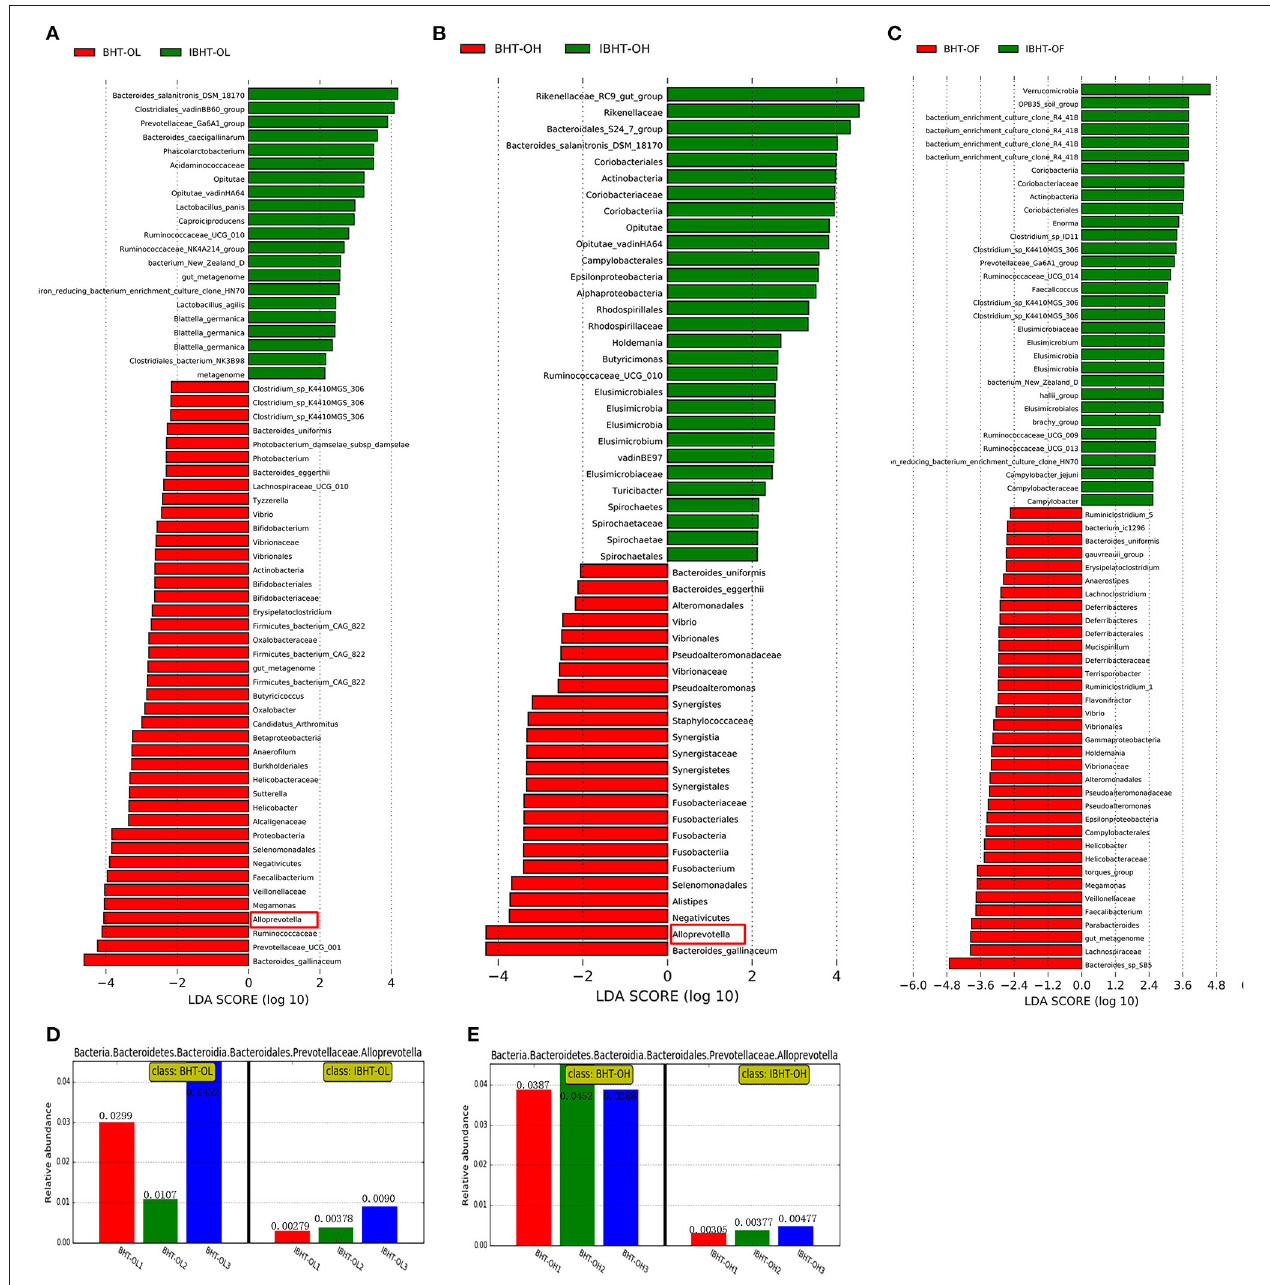
FIGURE 6 | Linear discriminant analysis (LDA) between Bian hens–20 weeks (BHT) and ISA Brown hens–20 weeks (IBHT) and abundance histograms of the dominant bacteria. (A) BHT-OL vs. IBHT-OL. (B) BHT-OH vs. IBHT-OH. (C) BHT-OF vs. IBHT-OF. (D,E) Abundance histograms of dominant fiber-degradation genus Alloprevotella in BH compared to those in